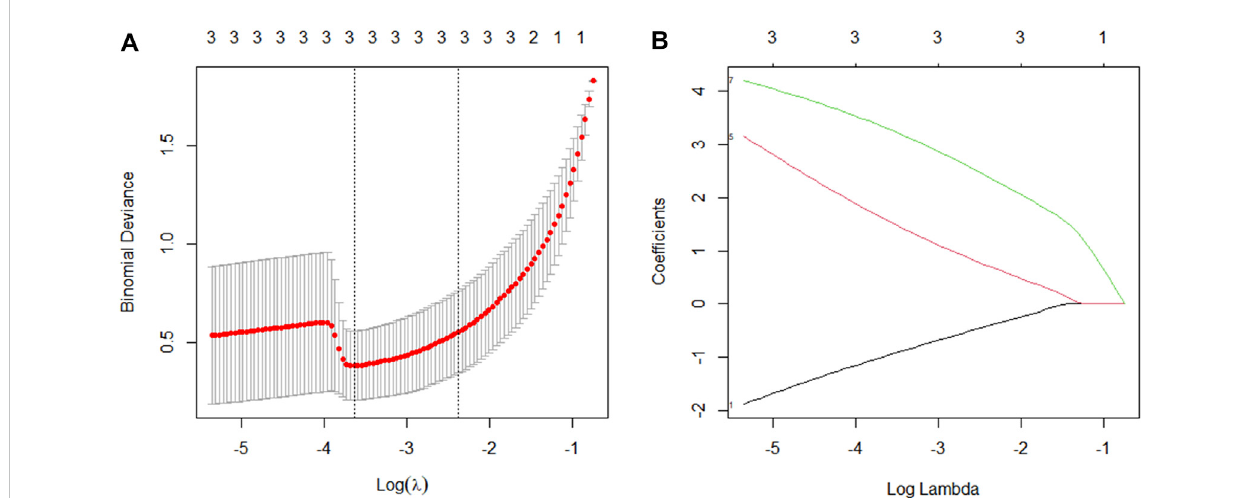
FIGURE 9 Factor selection using the Least Absolute Shrinkage and Selection Operator (LASSO) logistic regression model. (A) : The best parameter (lambda) selection in LASSO regression was selected using 10-fold cross-validation (through the minimum standard). Black vertical lines are drawn at the best